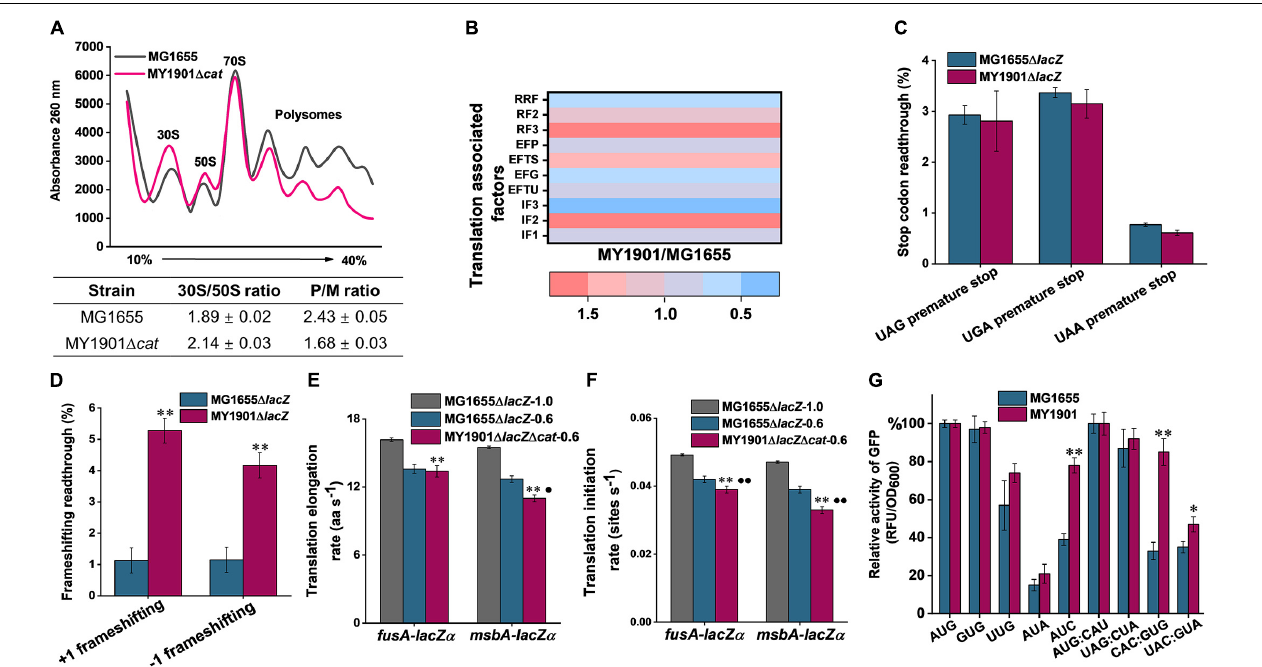
FIGURE 3 | Effects of SRP suppressor on translation efficiency. (A) Polysome profiles of the wild-type strain MG1655 and the suppressor strain MY1901 (cid:49) cat . Data represent the mean ± standard deviation of three independent experiments. (B) Fold changes in the expression of translation associated factors in strain MY1901relative to that in MG1655 ( Supplementary Data Set 1B ). (C,D) Effect of suppressor mutation on stop-codon (C) and frameshifting (D) readthrough. All data are averages of at least three independent experiments, and error bars represent the standard deviation of the mean. b-Galactosidase activities of strains harboring the mutant LacZ reporters were calculated relative to those of the same strain harboring the wild-type LacZ. Statistical significance compared to the suppressor strain MY1901 (cid:49) cat using Student’s t -test is indicated as follows: * P < 0.05; ** P < 0.01. (E) The translation elongation rates of FusA-LacZ α and MsbA-LacZ α under different growth rates (MG1655 (cid:49) lacZ , 1.0 h – 1 ; MG1655 (cid:49) lacZ , 0.6 h – 1 ; MY1901 (cid:49) lacZ (cid:49) cat , 0.6 h – 1 ). (F) The translation initiation rate of proteins was estimated based on their corresponding translation elongation rate. All data are averages of three independent experiments, and error bars represent the standard deviation of the mean value. Statistical significance compared to the strain MG1655 (cid:49) lacZ with growth rate 1.0 h – 1 using Student’s t -test is indicated as follows: * P < 0.05; ** P < 0.01. Statistical significance compared to the strain MG1655 (cid:49) lacZ with growth rate 0.6 h – 1 using Student’s t -test is indicated as follows: * P < 0.05; ** P < 0.01. (G) Initiation with various non-canonical start codons and non-initiator tRNA codons in the wild-type and suppressor strains. Relative activities of mutant GFP were calculated relative to that of the same strain harboring the wild-type GFP. The wild-type start codon was indicated as AUG, and the wild-type initiator tRNA was indicated as AUG: CAU. All data are averages of three independent experiments, and error bars represent the standard deviation of the mean value. Statistical significance compared to the strain MG1655 using Student’s t -test is indicated as follows: * P < 0.05; ** P <